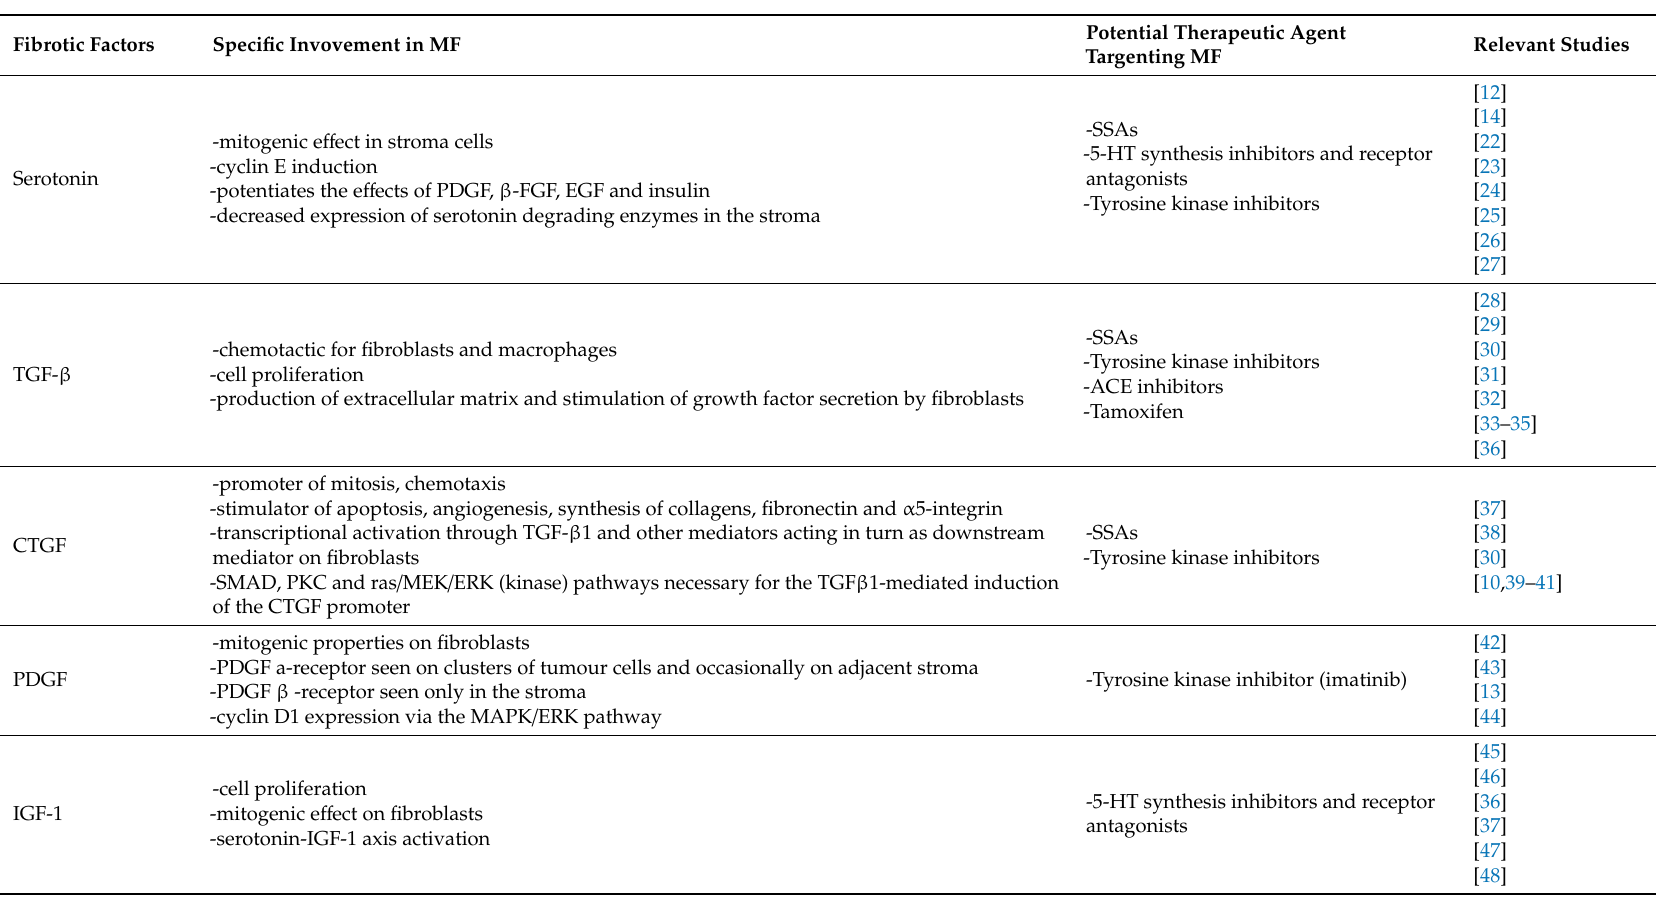
Table 1. Most studied profibrotic mediators secreted by small intestinal neuroendocrine neoplasms (SI-NENs) and their implications as potential therapeutic targets related to mesenteric fibrosis